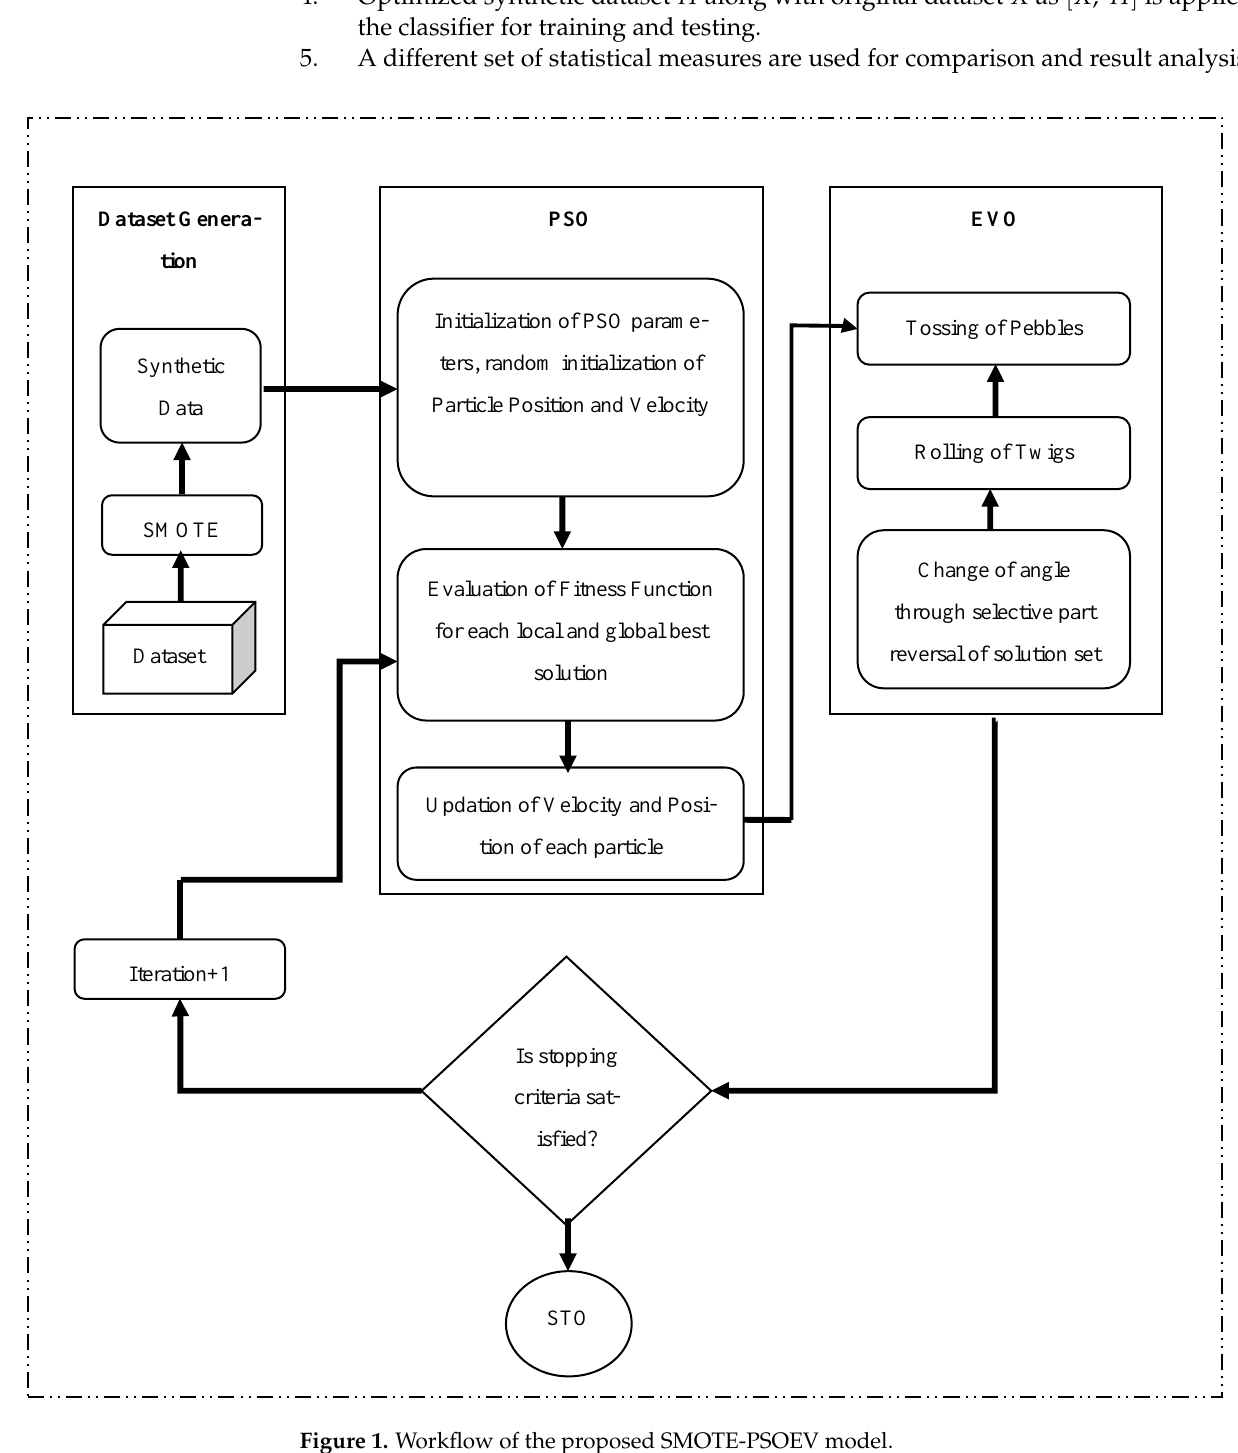
Figure 1. Workflow of the proposed SMOTE-PSOEV model.